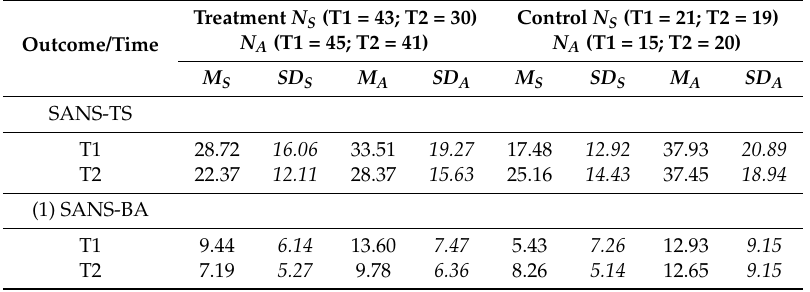
Table C1. Comparison of psychometric properties of participants with autism spectrum disorders (ASD) of our study, and schizophrenic participants in the study of Martin et al., 2016 [36], both part of the TESIS